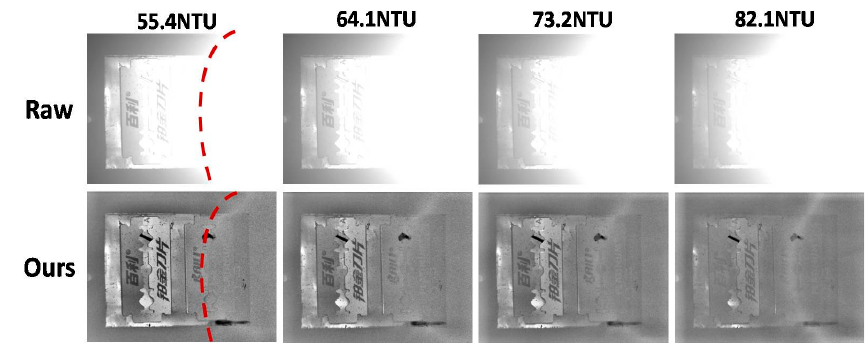
Figure 11. Processing results of HDOP object at different turbidities.